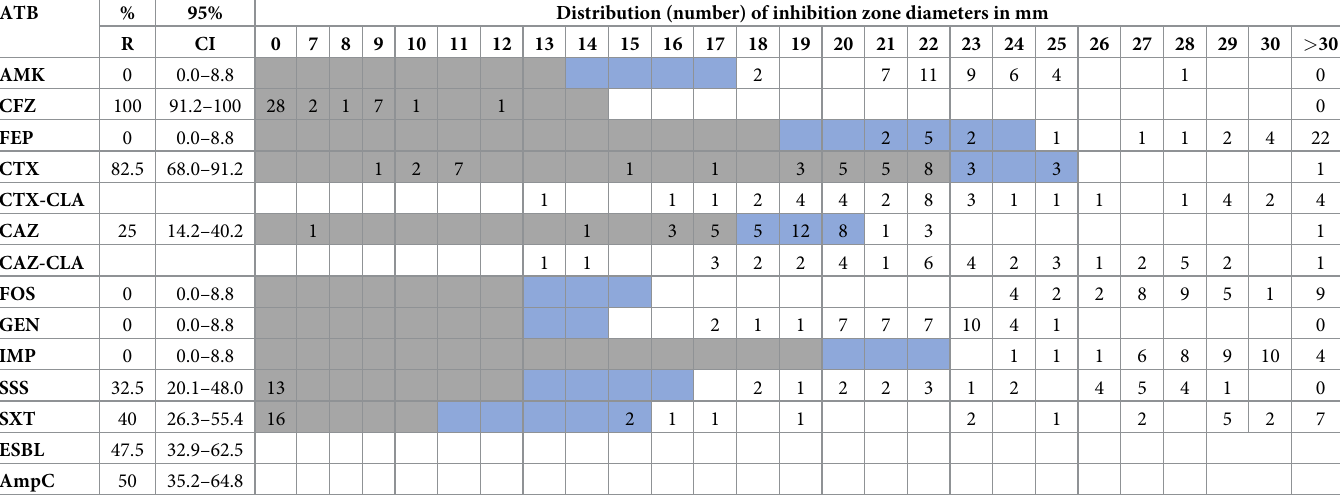
Table 5. Distribution of inhibition zone diameters of all E . coli isolates (n = 40) not susceptible to third-generation cephalosporins (i.e., second panel of antibiotics). ATB % 95% Distribution (number) of inhibition zone diameters in mm